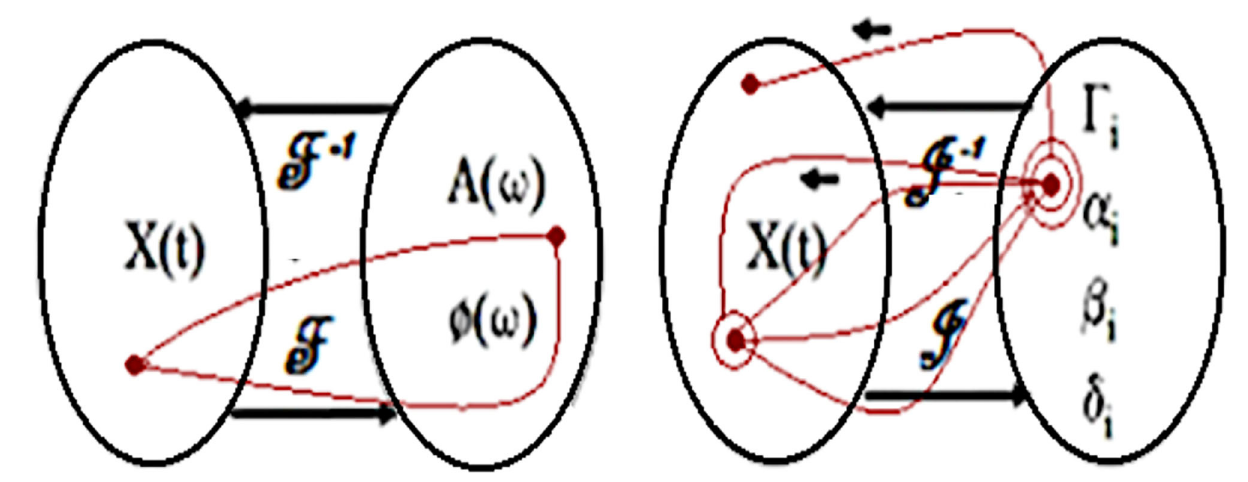
FIGURE 7 | Left: Correspondence between the signal and Fourier transform vector spaces. Right: Correspondence between the signal and Tailored to the Problem Specificity (TPS) transform vector spaces.